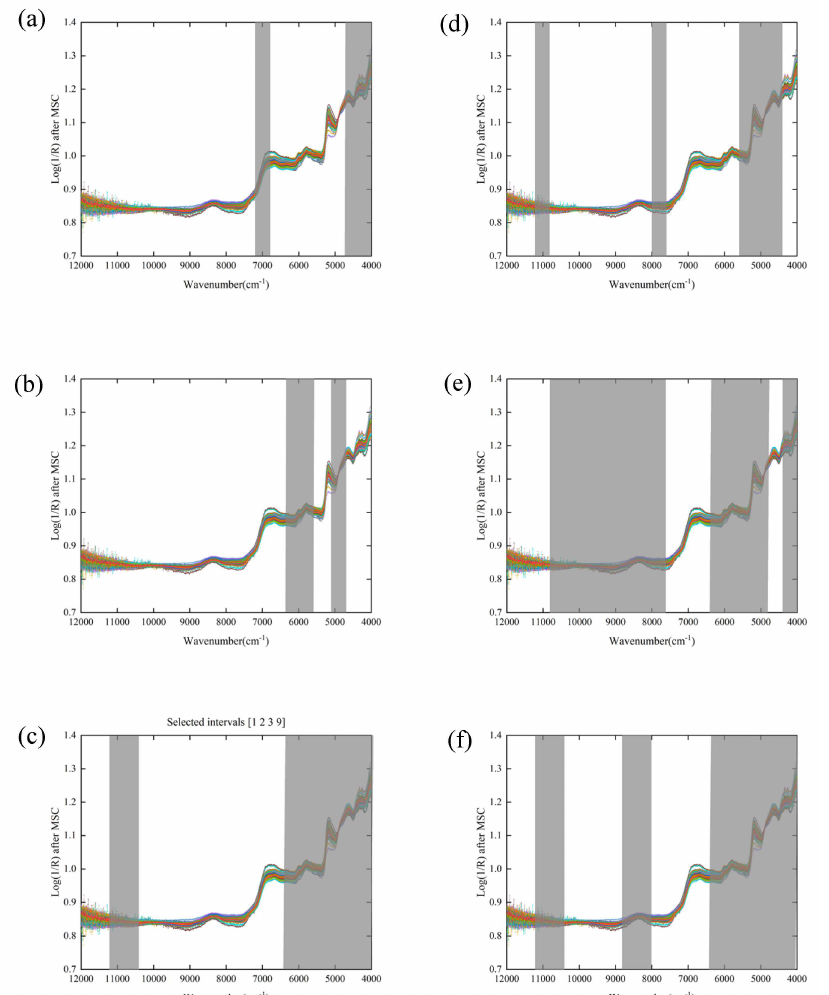
Figure 3. The optimization of spectral intervals, developed by siPLS and biPLS algorithm for quality compounds: ( a ) siPLS for TP; ( b ) siPLS for FAA; ( c ) siPLS for TP/FAA; ( d ) biPLS for TP; ( e ) biPLS for FAA; ( f ) biPLS for